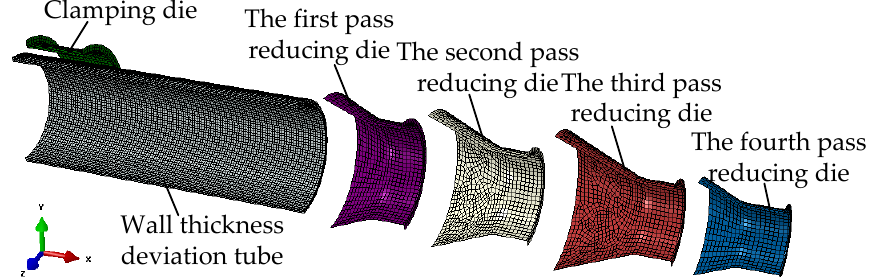
Figure 15. Finite element model.